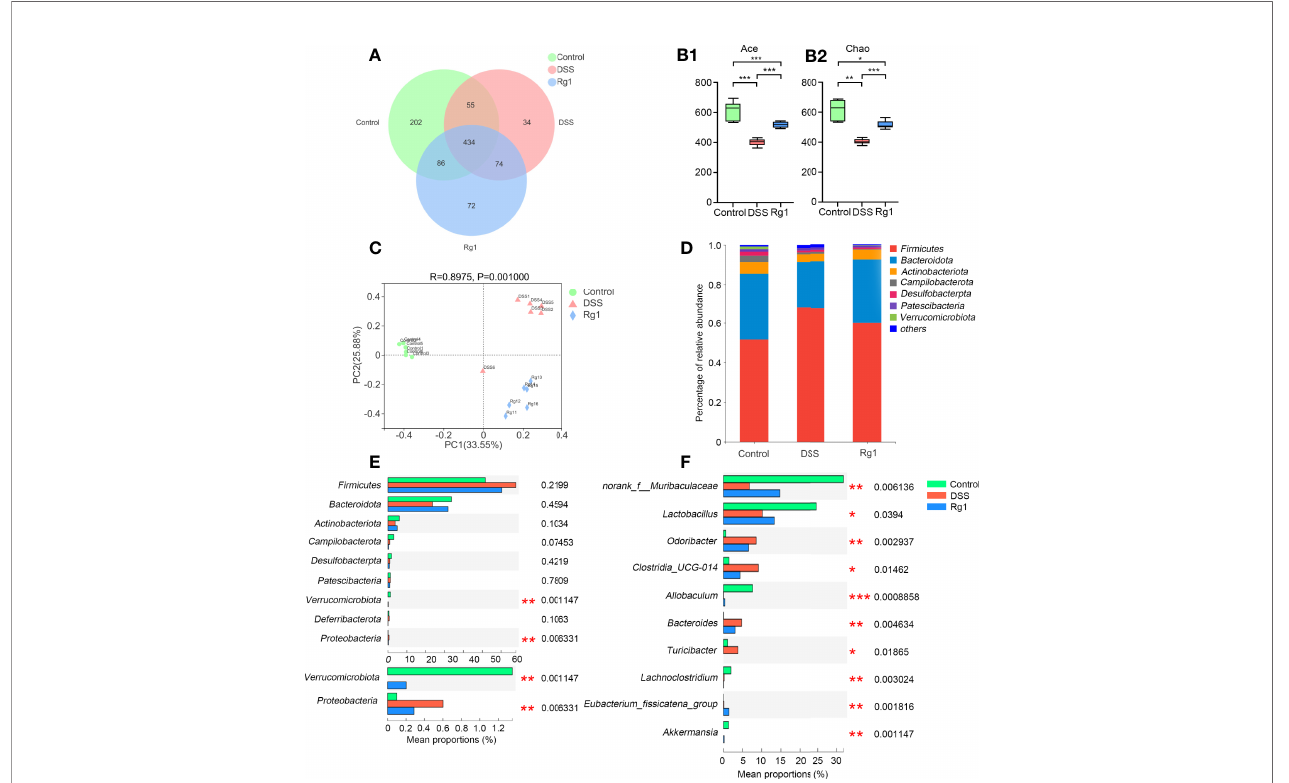
FIGURE 3 | The change of the gut microbiota after DSS and Rg1 intervention. (A) The Venn diagram shows the overlap of OTUs in each group. Alpha diversity indicators: Ace (B-1) and Chao (B-2) show the change in community richness. The bars represent the maximum, upper quartile, median, lower quartile, and minimum from top to bottom. (C) PCoA analysis re fl ects the similarities and differences among the three groups. (D) Histogram shows the percent of community abundance on the phylum level. (E) The differential bacteria among three groups at the phylum level. (F) The differential bacteria among three groups at the genus level. P < 0.05 was considered to be statistically signi fi cant. Signi fi cance levels are indicated as * P < 0.05, ** P < 0.01, and *** P <